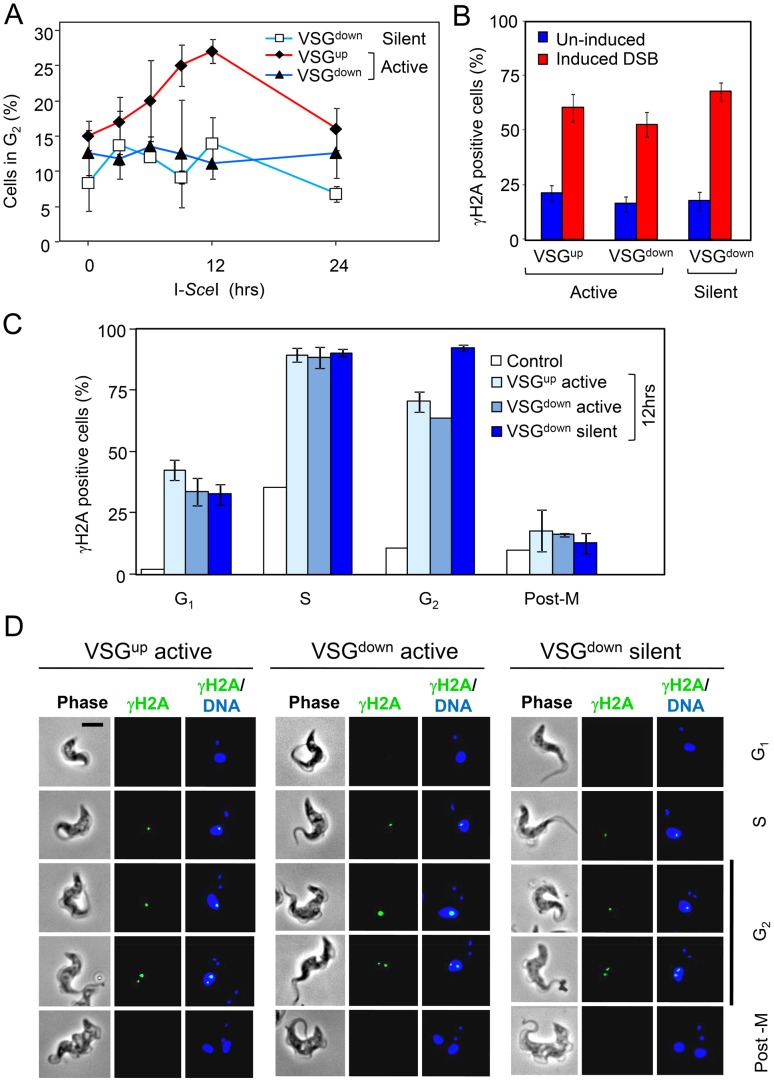
Distinct subtelomeric DNA double-strand break responses.(A) Cell-cycle phase was determined by DAPI-staining and defined by the number of nuclei (N) and kinetoplasts (K); G2, a single nucleus and two separate kinetoplasts (n = 200 at each time point). Error bars, SD. (B) γH2A accumulates at sub-nuclear foci in response to a DSB at a BES. Proportions of nuclei with foci were counted in uninduced (0 h) cells and 12 h after I-SceI-induction (n = 200 at each time point). Error bars, SD. (C) γH2A foci are enriched in S-phase and G2. Cell-cycle phase was defined as above; G1, a single nucleus and a single rounded kinetoplast; S-phase, a single nucleus and an elongated kinetoplast; post-mitotic (post-M), two nuclei and two kinetoplasts (n = 100 for each bar). Error bars for BES-break strains, SD. Control; uninduced cells. (D) Immunofluorescence microscopy analysis of γH2A. Gallery of representative images showing cells with focal accumulation of γH2A during the cell-cycle 12 h after I-SceI induction. Scale bar, 5 µm.